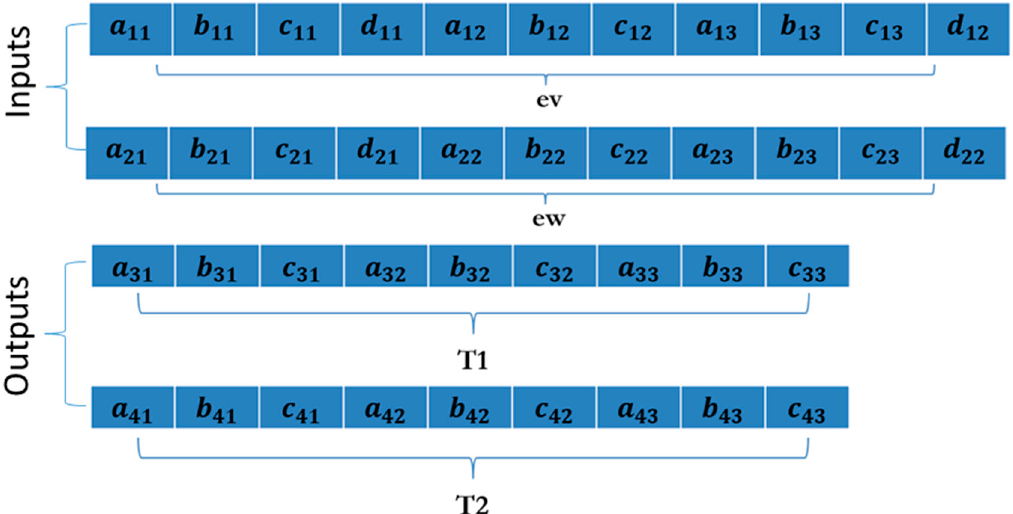
Figure 2. Composition of the individuals in GSO and the proposal fuzzy galactic swarm optimization type-1 (FGSO1) and fuzzy galactic swarm optimization interval type-2 (FGSO1T2).